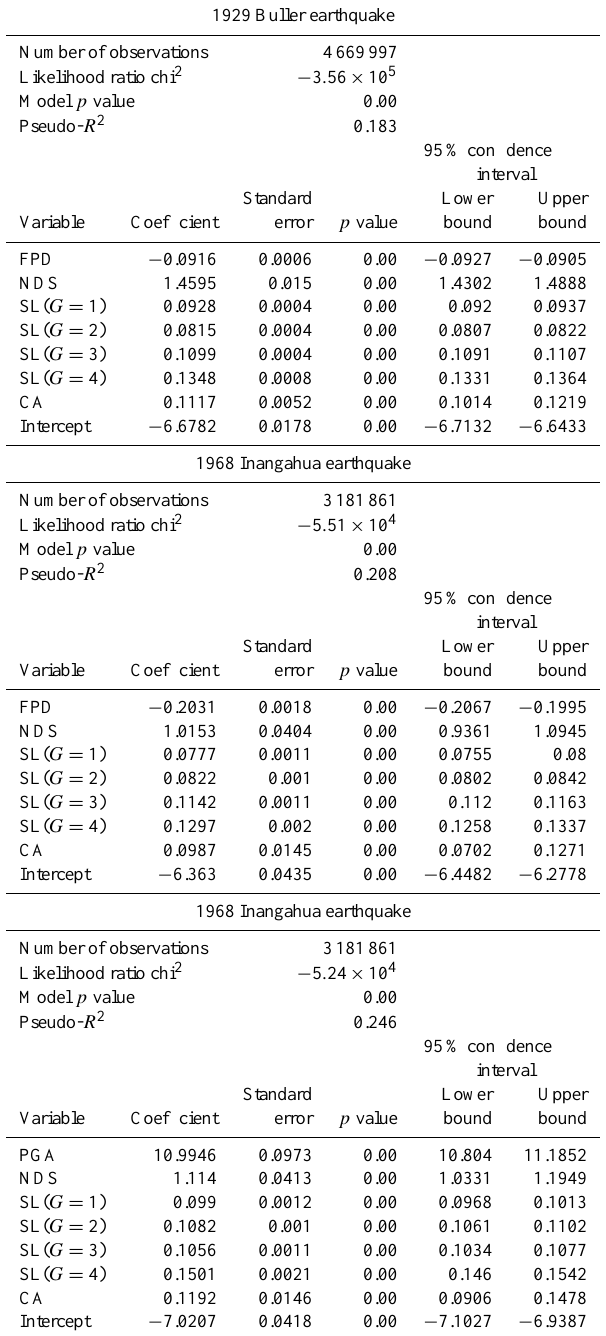
Table 4. Logistic regression output coefficients and fit